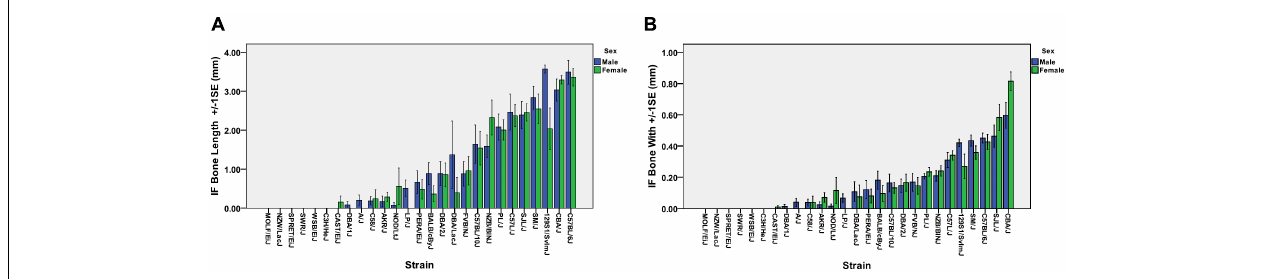
FIGURE 3 | Mean IF bone lengths and widths across all strains. (A) IF bone lengths and (B) IF bone widths. Male, blue boxes and females green boxes.